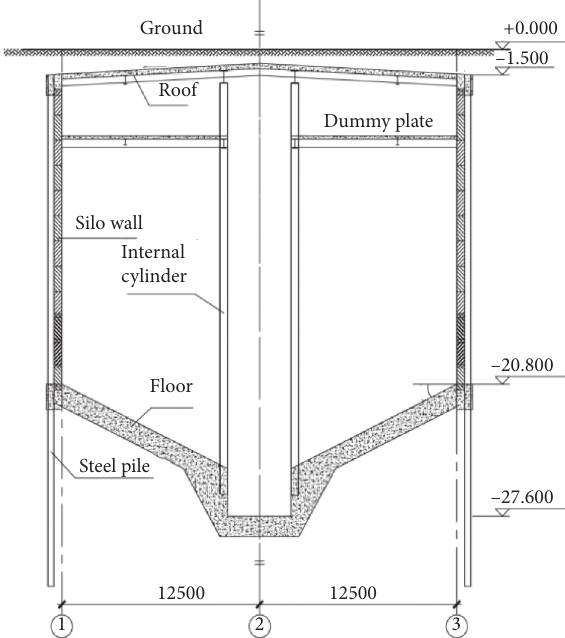
Figure 1: Section diagram of the prefabricated underground silo.